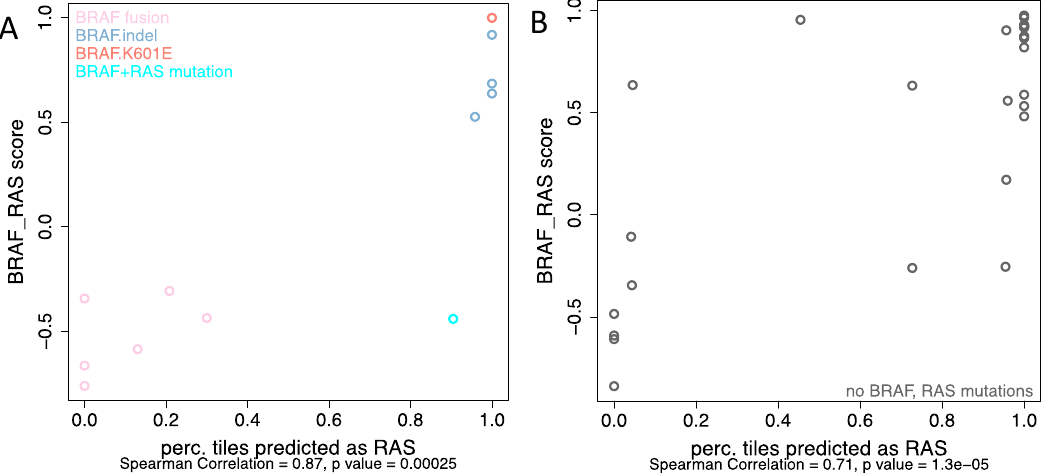
Figure 4. The correlation between BRS score and the possibility of accurate prediction per tile image for ( A ) non-V600E BRAF mutations as well as BRAF -fusions, ( B ) samples without known BRAF or RAS alterations.